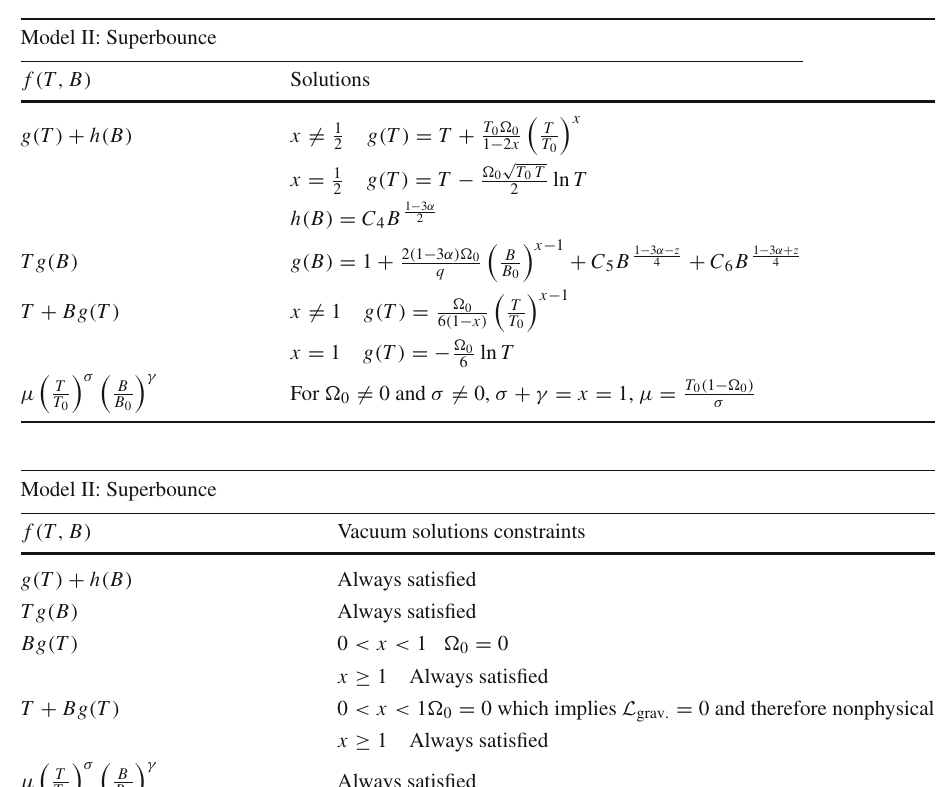
Table 2 A summary of the necessary parameter constraints which need to be satisfied if the reconstructed symmetric bounce cosmological f ( T , B ) models are to realise the vacuum constraint. Overall, only the additive ansatz is able to satisfy this constraint while also realising the cosmology Table 3 A summary of the reconstructed Lagrangian solutions for the superbounce